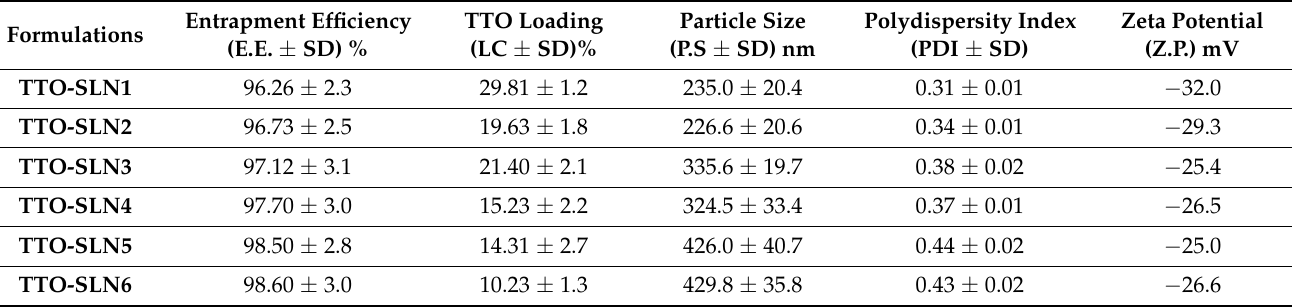
Table 2. Physicochemical properties of TTO-SLNs (entrapment efficiency, loading capacity, particle size, zeta potential, and polydispersity